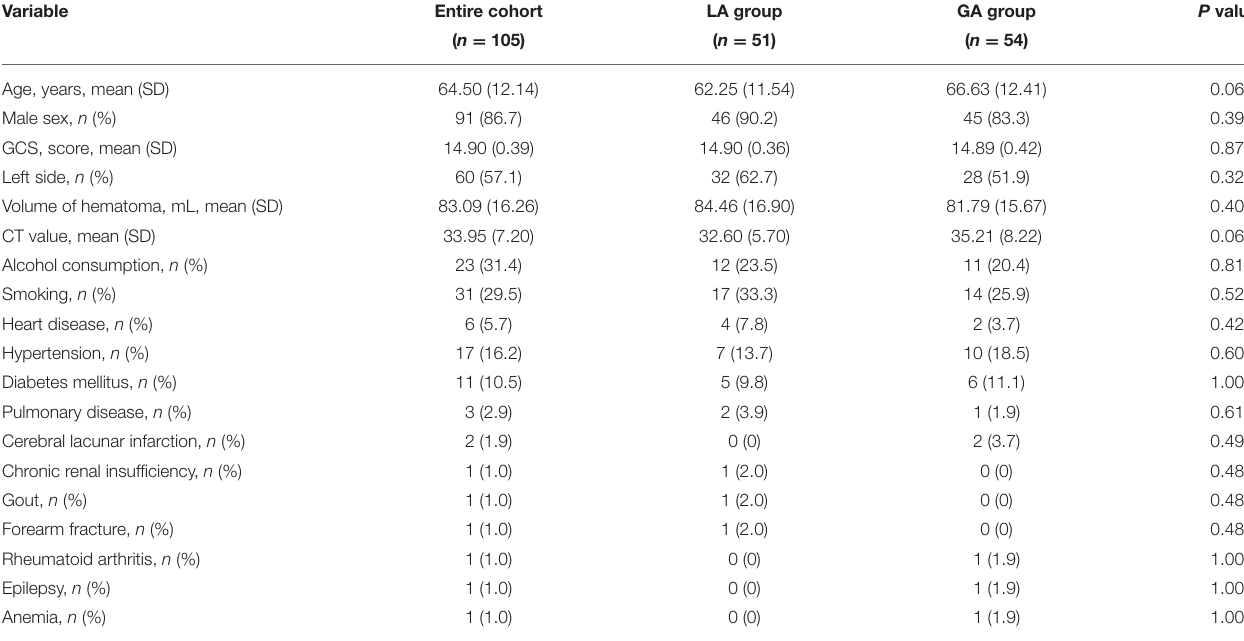
TABLE 1 | Baseline information.